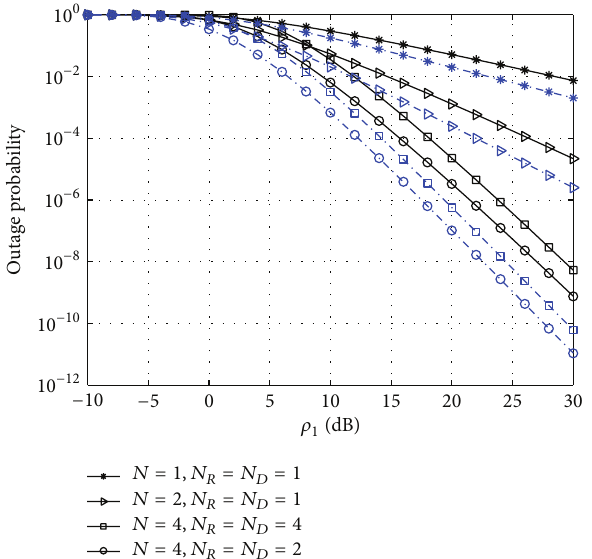
Figure 7: Comparison of AF relaying system with MRC/MRT and DF relaying system with MRT versus SNR ( 𝜌 1 = 𝜌 2 , 𝜌 𝑅,𝑖 = 𝜌 𝐷,𝑗 = = 0 0 dB, ∀𝑖 , 𝑗 , 𝛾 th